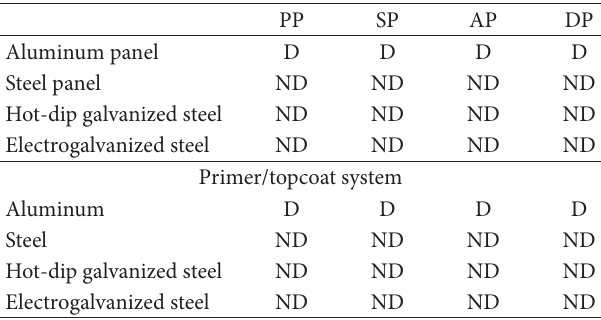
Table 4: Results of the impact resistance test of different primers and primer/topcoat